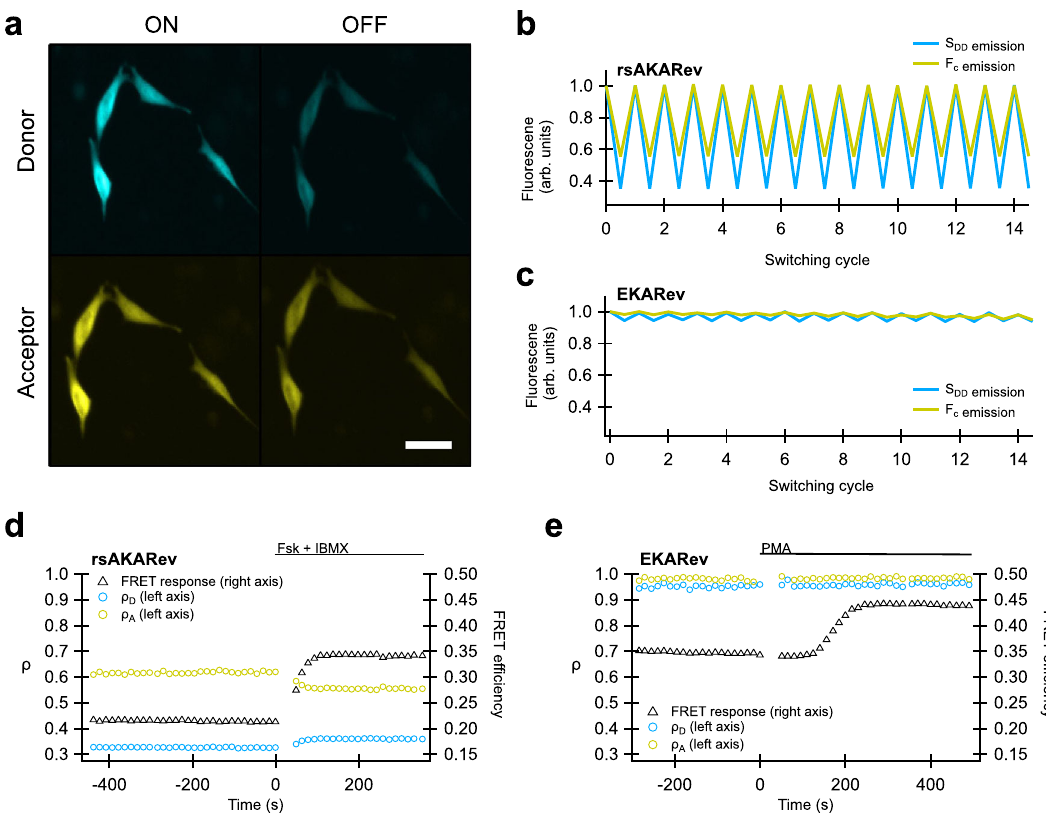
Fig. 3 Photochromism of rsAKARev and EKARev expressed in HeLa cells. a Representative fl uorescence images of the donor ( S DD ) and acceptor ( S DA ) fl uorescence of rsAKARev before and after off-switching. Scale bar, 40 μ m. b , c Time-course of the donor and sensitized acceptor emission of rsAKARev ( b ) and EKARev ( c ) during multiple irradiation cycles. d , e Representative responses of a HeLa cell expressing rsAKARev ( d ) or EKARev ( e ) during stimulation of PKA or ERK activity. Time-traces are colored as indicated. PKA activity was stimulated with forskolin (Fsk, 50 μ M) and IBMX (100 μ M), ERK activity with PMA (1 μ